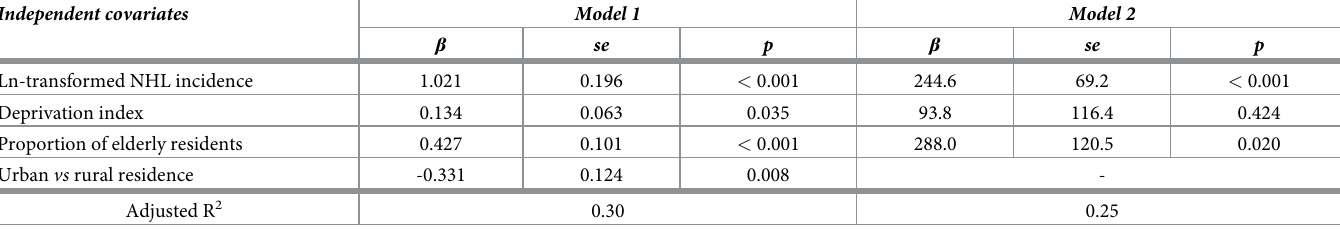
Table 1. Parameters of the multiple regression analysis with cumulative incidence of COVID-19 as the outcome: Model 1: Weighted regression, all communes; out- come: ln-transformed COVID-19 incidence; covariates: ln-transformed standardized NHL incidence, deprivation index, proportion of elderly residents, and urban vs rural residence. The last three are not ln-transformed; model 2: conventional regression, 61 administrative units: outcome: cumulative incidence of COVID-19; covari- ates: standardized NHL incidence, deprivation index, proportion of elderly residents. Independent